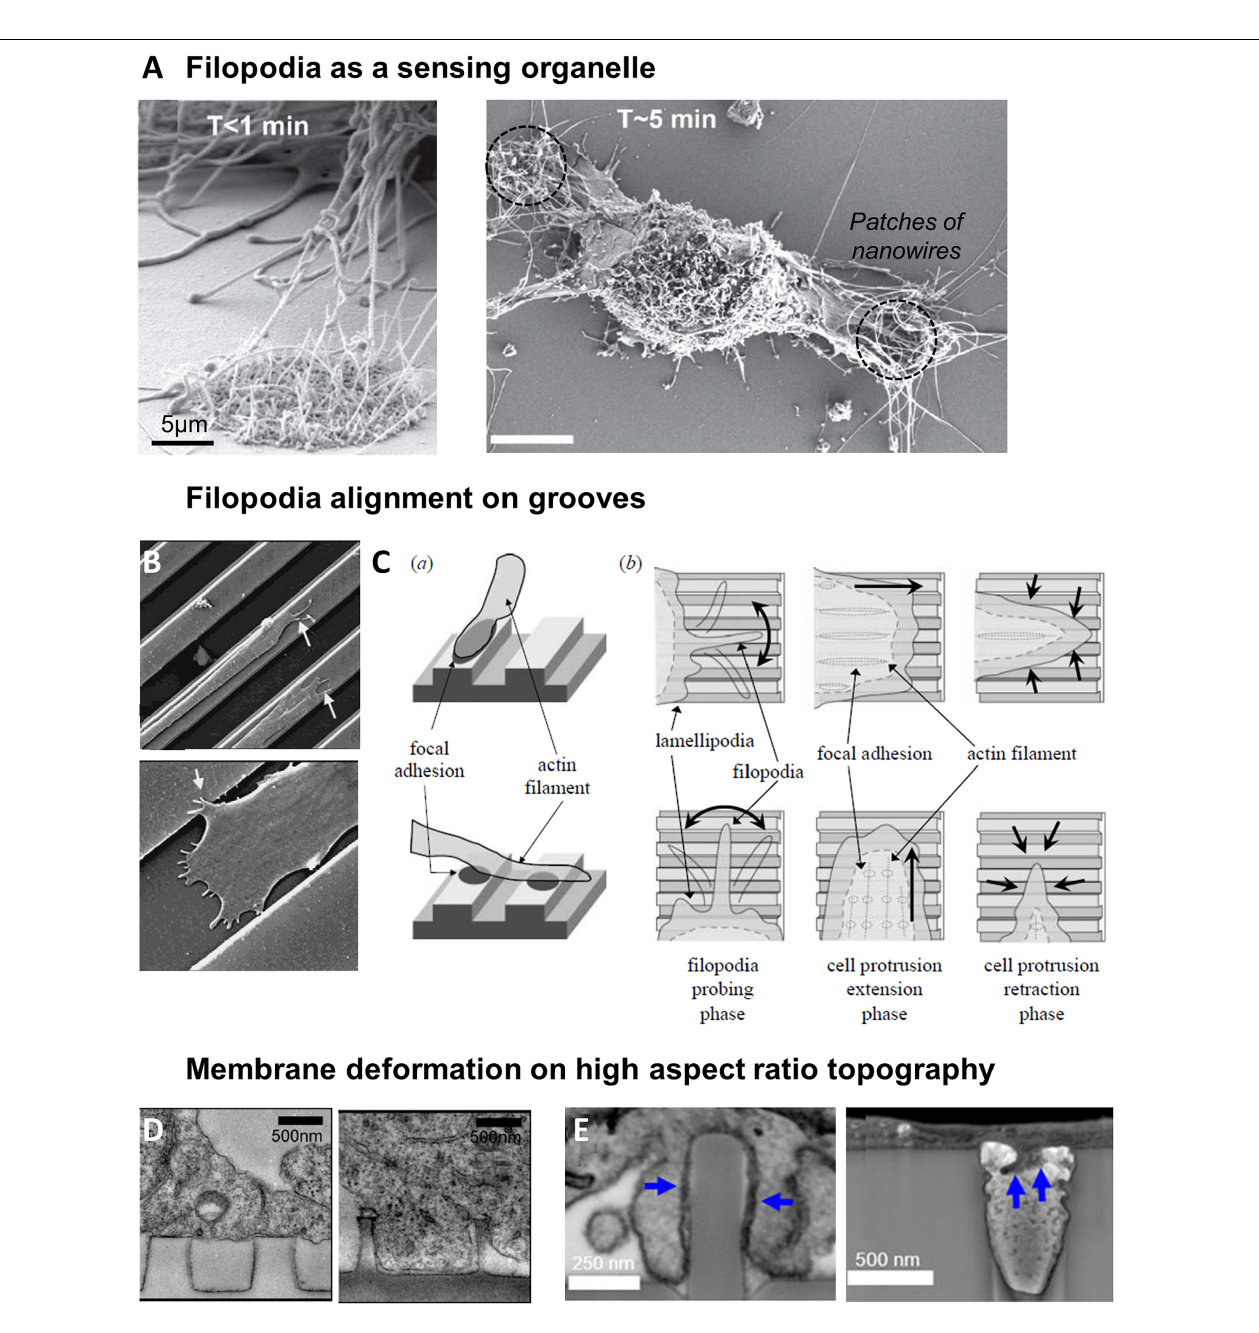
FIGURE 4 | Filopodia as a sensor of topography. (A) Sensing of nanowires by filopodia of fibroblasts. Shortly after plating, filopodia explore both flat and nantopography (left). After 5 min, filopodia on flat surface have retracted (right). From Albuschies and Vogel (2013). (B) SEM image of epithelial cell sending filopodia along ridges and grooves. Reproduced with permission from Dalton et al. (2001). (C) Model of cell alignment on grooves by filopodia probing and perpendicular filopodia retraction. Reproduced with permission from Fujita et al. (2009). (D) Membrane deformation of cortical neurons on nanopillars seen by TEM. On pillars of 500 nm diameter, 1 µ m spacing, cell body rests on top of the pillars (left). On 200 nm diameter pillars with the same center-to-center distance, membrane deforms to engulf the pillars (right). Reproduced with permission from Hanson et al. (2012). Copyright 2012 American Chemical Society. (E) FIB SEM cross sections reveal that plasma membrane wraps tightly around nanopillars with 400 nm diameter (left), but hardly deforms into 400 nm diameter nanopores (right, blue arrows). Reproduced with permission from Santoro et al. (2017). Copyright 2017 American Chemical Society.